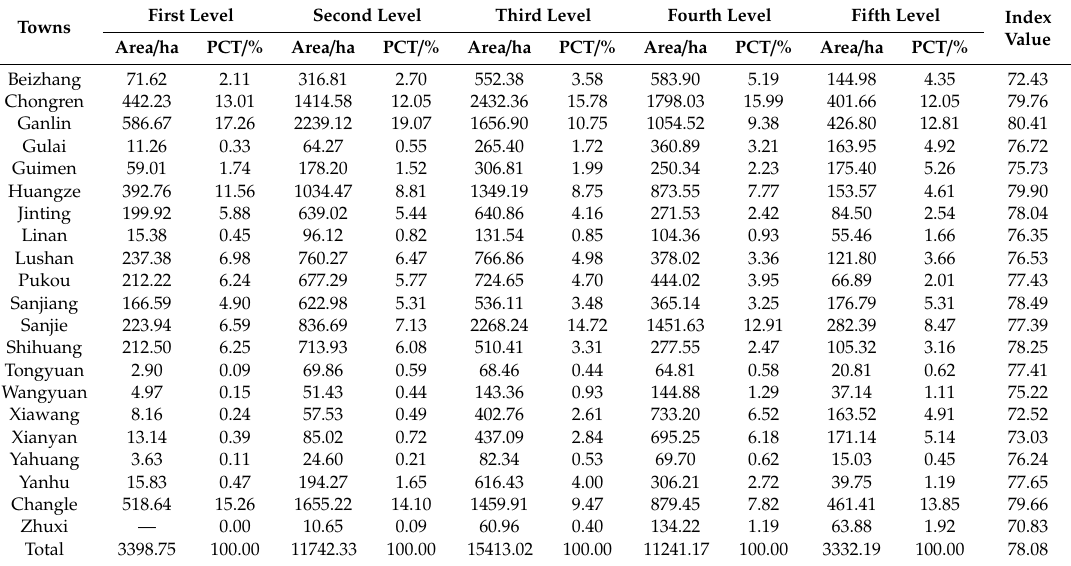
Table 2. Quality grade statistics of cultivated land in various towns in the study area.